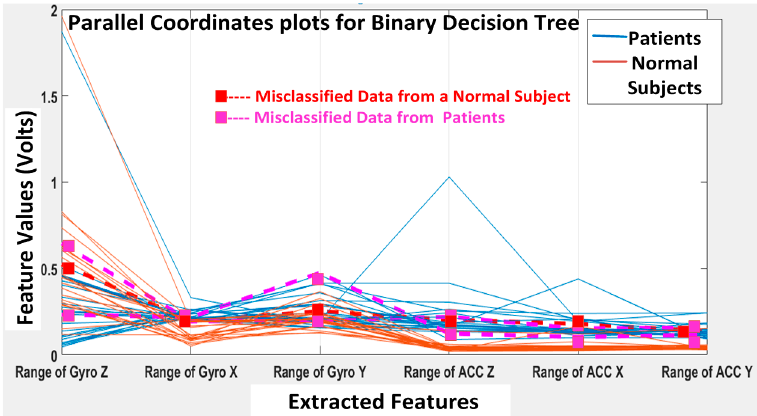
classification model with the TPR and False Positive Rate (FPR).